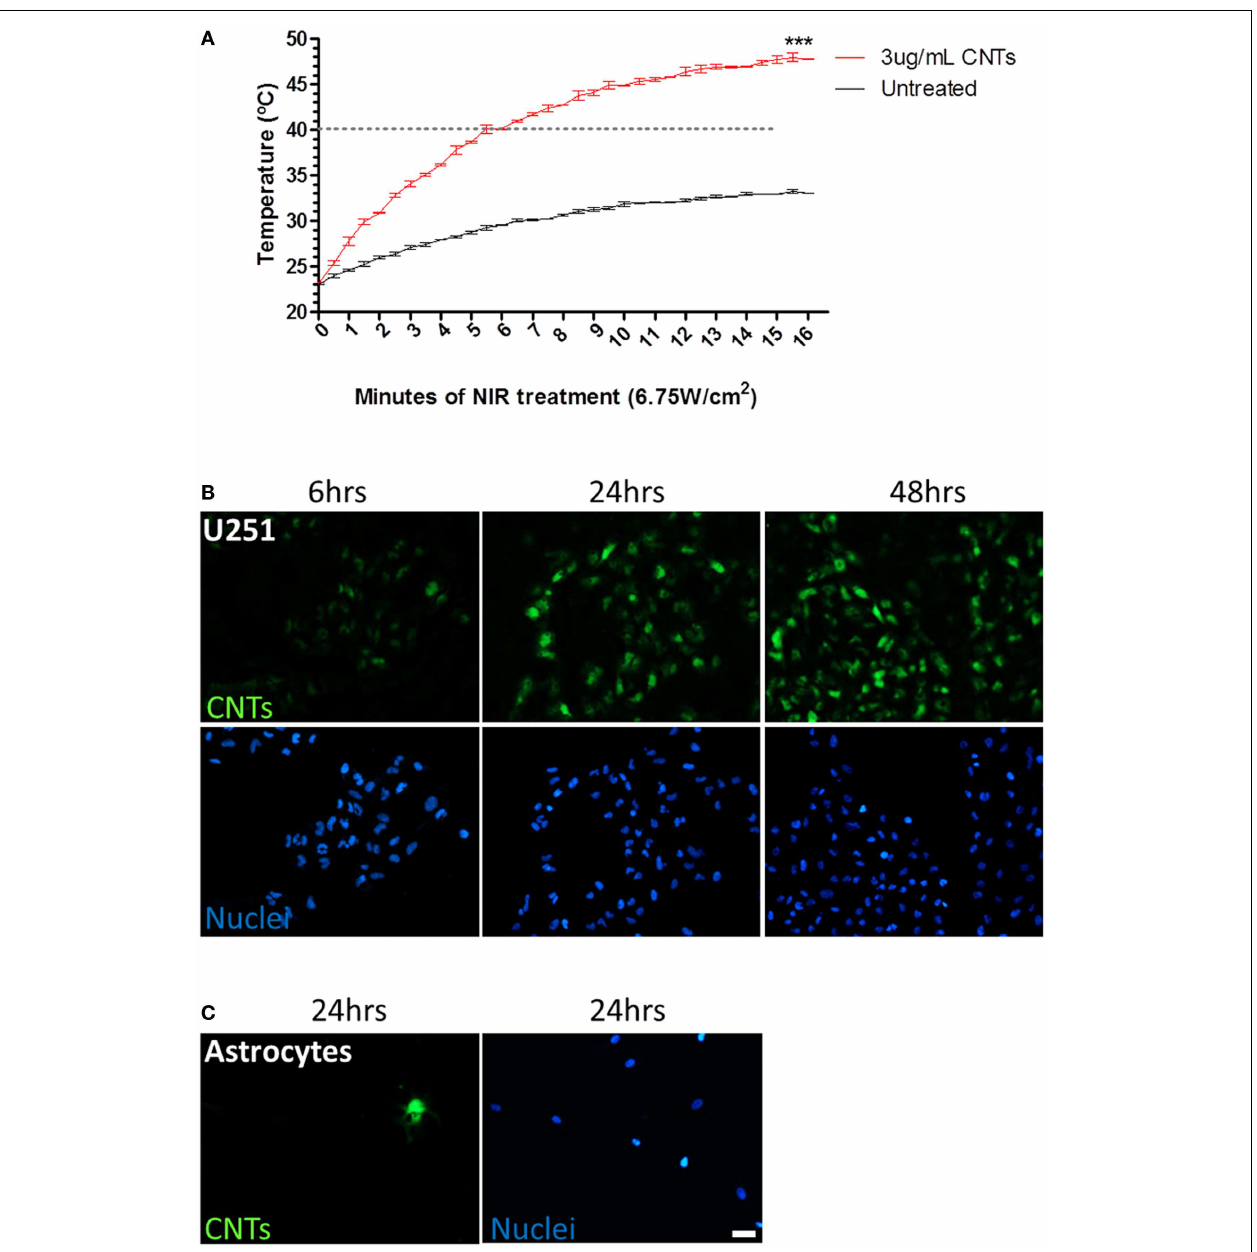
(40°C). (B) U251 glioma cells were incubated with fluorescein-labeled CNTs (green); maximum internalization was observed after 24h. (C) Astrocytes were cultured with fluorescein-labeled CNTs for 24h; few cells incorporated CNTs.Total numbers of cells were identified by Hoechst nuclear staining (blue). Scale bar is 20 µ